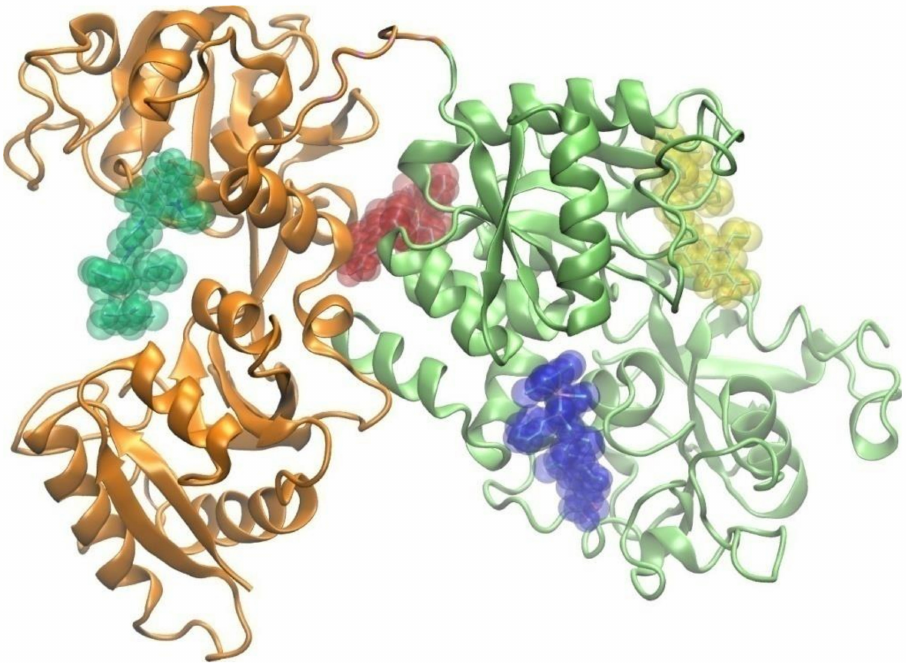
Figure 10. The predicted binding pockets within apo-Tf structure. The N- and C-lobes of apo-Tf are shown in orange and light green colors. The location of #1, #2, #3, and #4 binding sites is specified by the docked IrPCp shown in blue, red, yellow, and dark green colors,